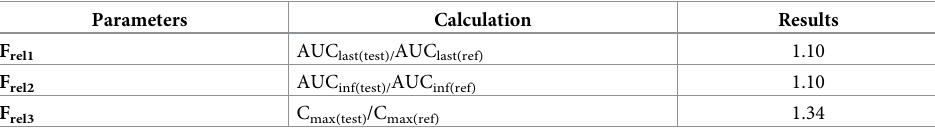
Table 11. Relative Bioavailability of test genistein formulation versus marketed genistein